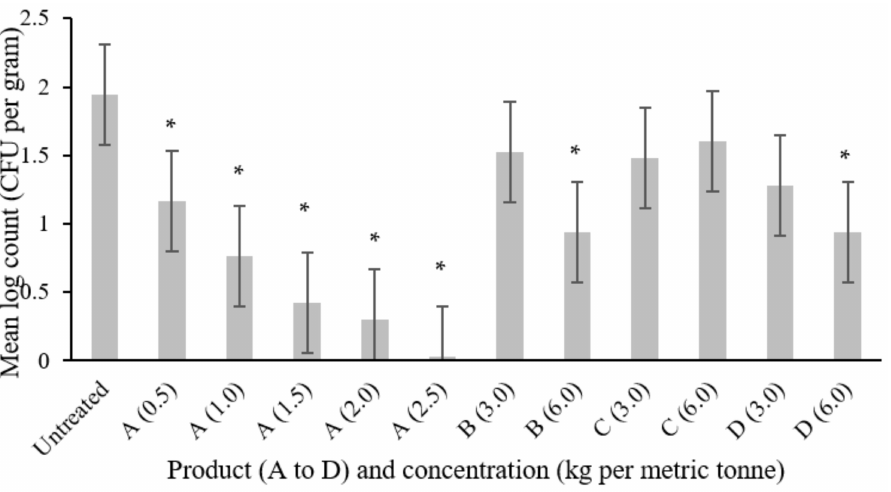
Figure 2. Log 10 count of Salmonella DT104 in feed treated with each product after 24 h contact with products as described in Table 2. * indicates statistically significant difference from the untreated control using Dunnett’s comparison. Error bars indicate 95% confidence